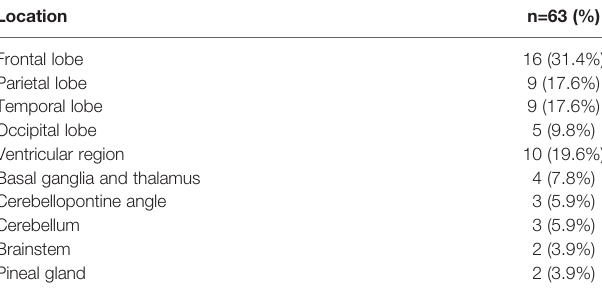
TABLE 2 | Mass location of the 51 PCNS-DLBCL patients (63 lesions) at diagnosis.